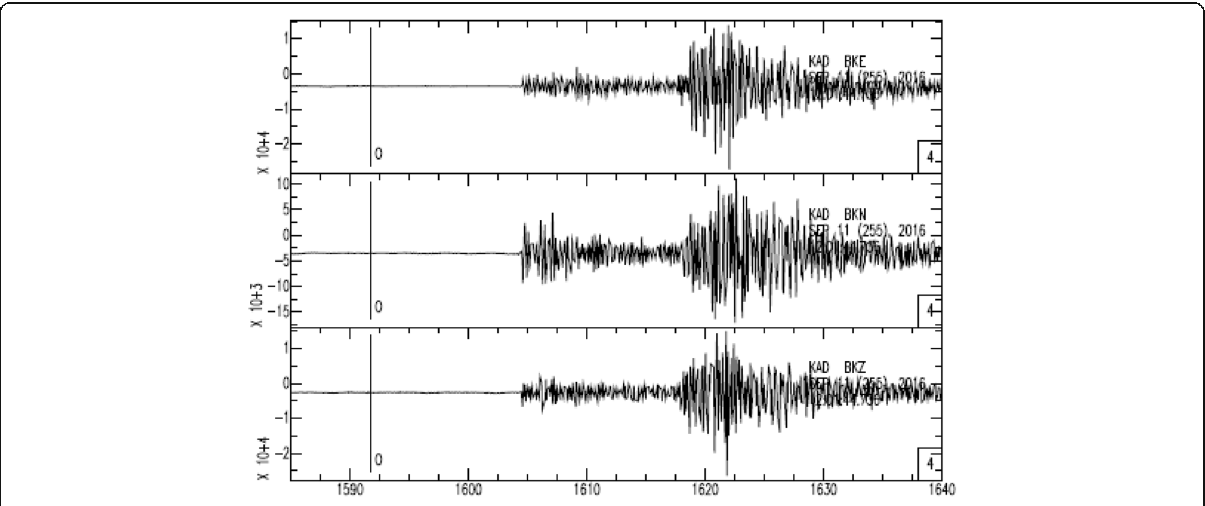
Fig. 12 Seismograms of the first tremor (Source: Centre for Geodesy and Geodynamics